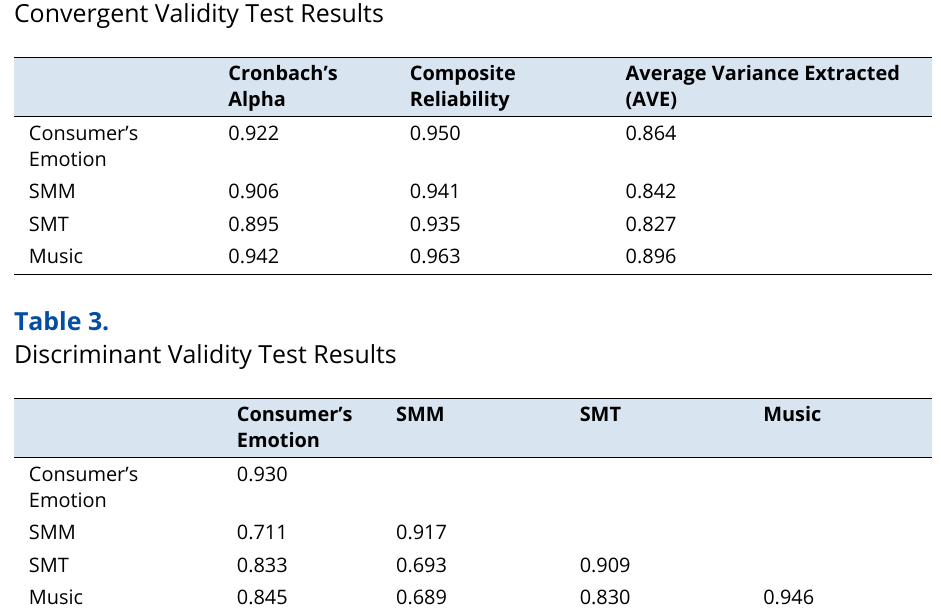
Convergent Validity Test Results